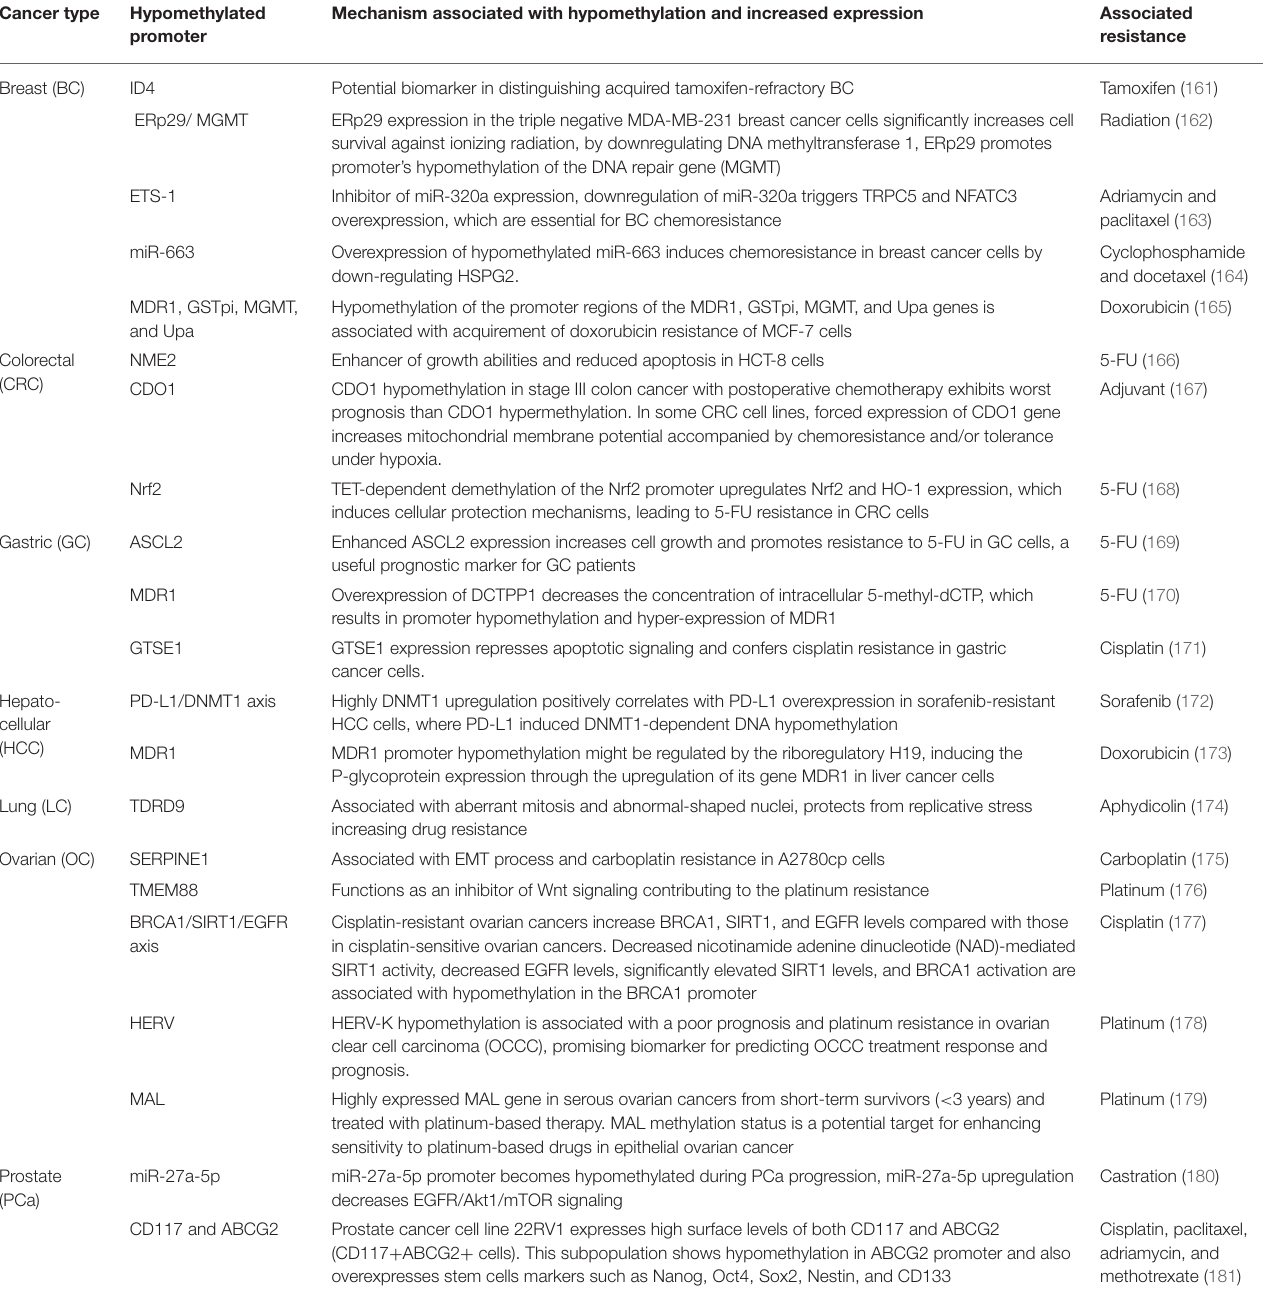
TABLE 4 | Hypomethylation associated with chemotherapy resistance in